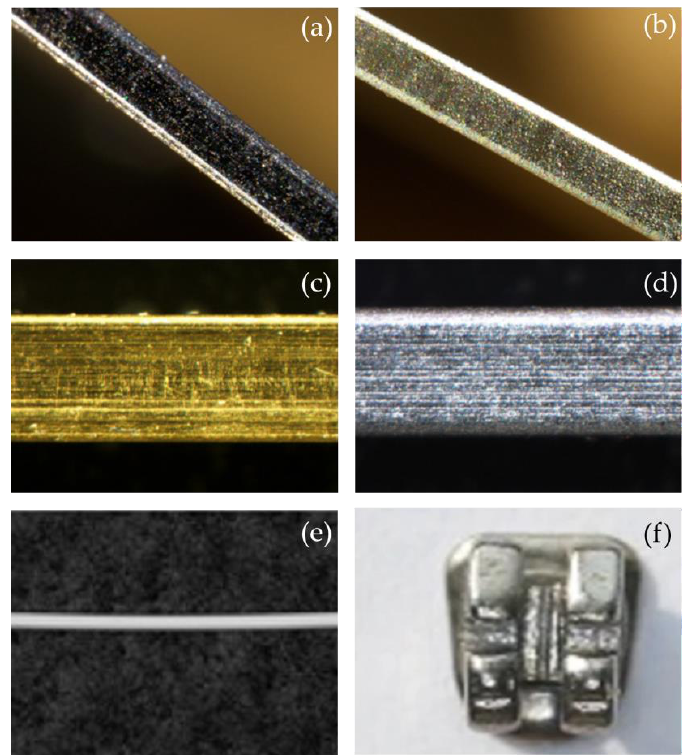
Figure 1. Functional coatings that have been applicated on brackets and archwires. ( a ) nickel (Ni) + molybdenum disulfide (MoS 2 )-coated stainless steel (SS) archwire; ( b ) Ni + tungsten disulfide (WS 2 )- coated SS archwire; ( c ) titanium nitride (TiN)-coated SS archwire; ( d ) TiN-coated nickel-titanium (NiTi) archwire; ( e ) polymer-coated wires (microcoated stainless steel wire ® , G&H Wire Company, Franklin, IN, USA); ( f ) polydopamine and blue fluorescent hollow carbon dots (PDA-HCD) brackets. Adapted with permission from